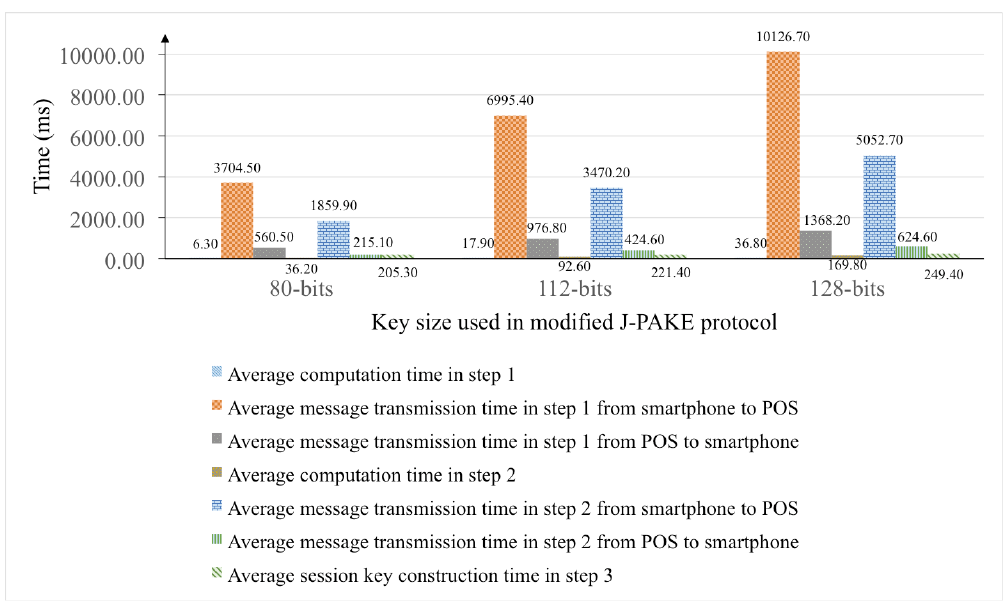
Figure 15. The average duration of each step in session key construction phase over three different key sizes in modified J-PAKE protocol.